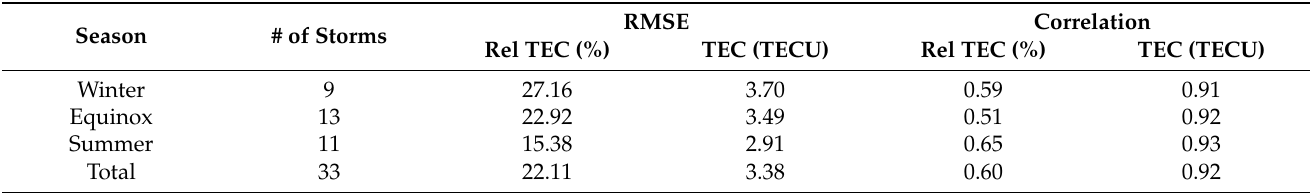
Table 4. Performance of the storm-time model in terms of RMSE and correlation for relative TEC and TEC for the test dataset. The classification into seasons was performed according to the DOY listed in Table